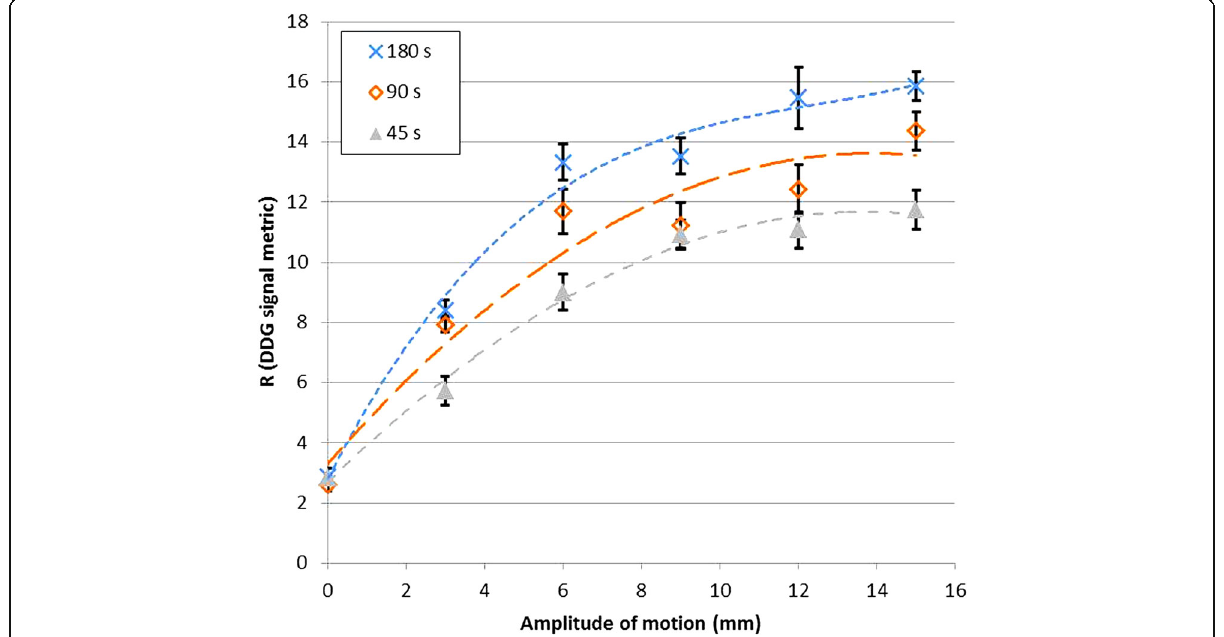
Fig. 1 Relationship between R and motion amplitude found for a phantom performing respiratory-like motions. The maximum displacement was 30 mm, corresponding to a 15-mm amplitude. Lines of best fit are shown (using third-order polynomials). Results are presented for scan durations equal to 180 s, 90 s and 45 s. Error bars represent standard errors on the